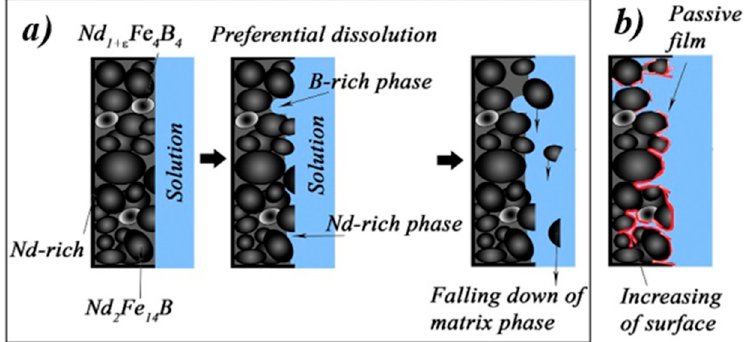
Figure 12. Schematic illustration of leaching process on the surface of NdFeB magnet scrap in ( a ) H 2 SO 4 , ( b ) mixture of H 2 SO 4 and H 2 C 2 O 4 [60]; published by Elsevier, 2020